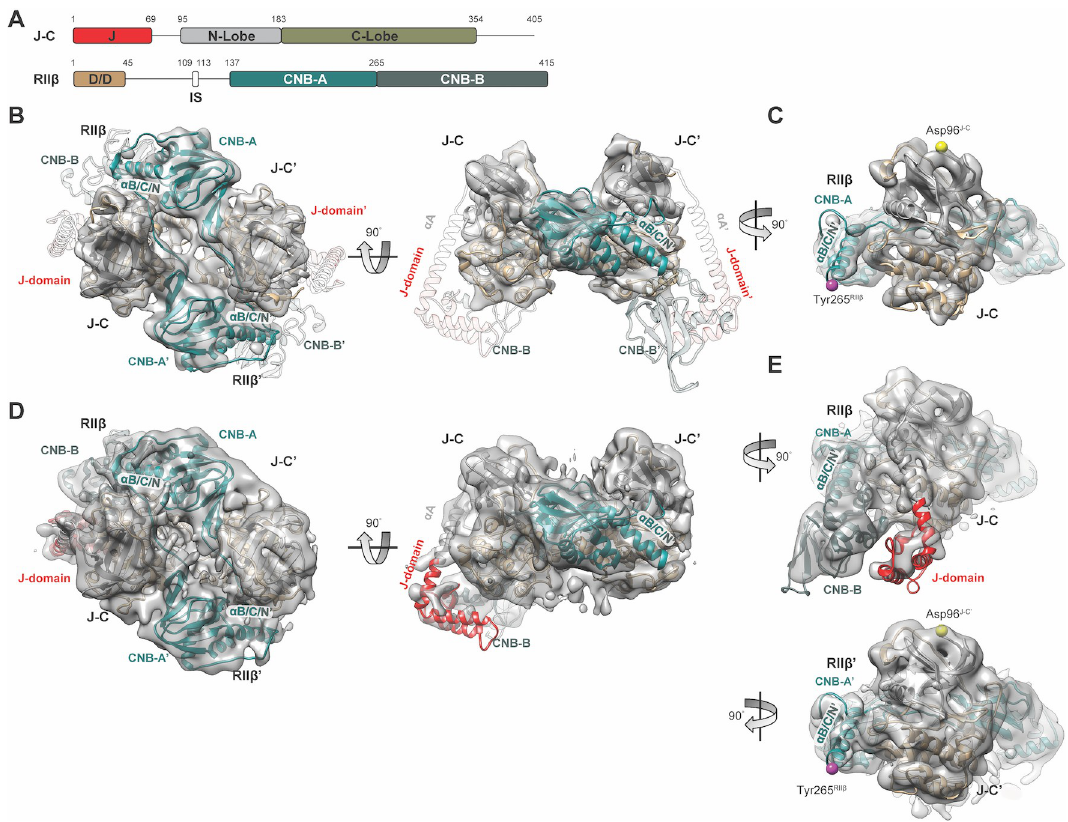
Fig 1. Cryo-EM structure of the RII β 2 J-C 2 holoenzyme. ( A ) Domain diagram and color coding of RII β 2 J-C 2 holoenzyme. ( B, C ) Cryo-EM structure the RII β 2 J-C 2 holoenzyme (PDB = 6WJG) at 6 Å with C2 symmetry imposed. (C) The EM density of the RII β 2 J-C 2 holoenzyme starts at Asp96 J-C (equivalent to Asp41 C in the WT C subunit) in the N-terminus of the J-C subunits and ends at Tyr265 RII β in the RII β subunit. The density for the A-helix, J-domain, and CNB-B domains are missing. ( D, E ) Structure of the RII β 2 J-C 2 holoenzyme structure (PDB = 6WJF) after classification reveals presence of ordered J-domain and CNB-B domain. (E) One of the protomers of RII β 2 J-C 2 holoenzyme has ordered J-domain and CNB-B domain, whereas J-domain, A-helix, and CNB-B domain are flexible in the other protomer. CNB, cyclic nucleotide binding; cryo-EM, cryo-electron microscopy; PDB, Protein Data Bank; WT,